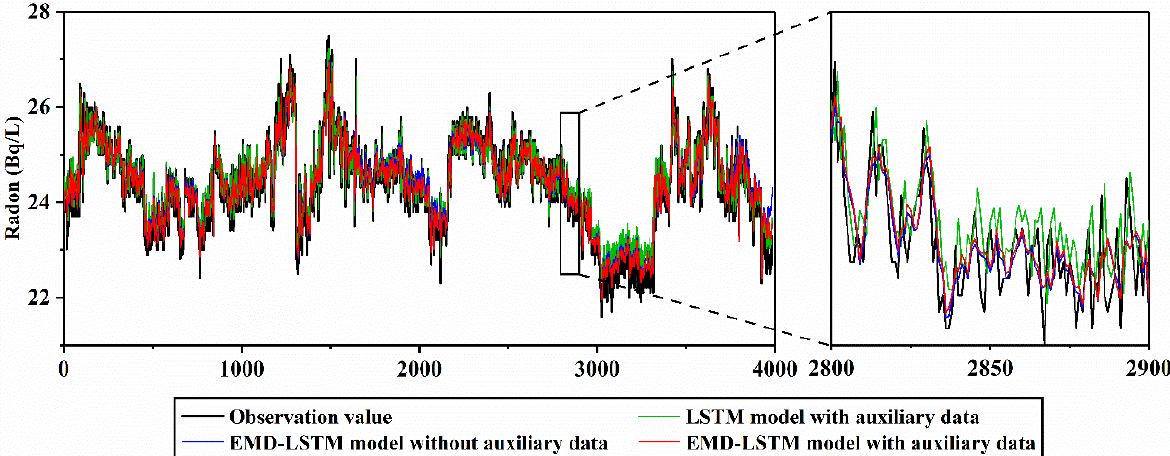
Figure 8. The predicted results of different models, including the LSTM model with auxiliary data, the EMD-LSTM model without auxiliary data, and the EMD-LSTM model with auxiliary data. The R 2 and the RMSE values of the EMD-LSTM model within the validation set without auxiliary data were 0.949 and 0.273, respectively. It demonstrated that the EMD- LSTM model still had good predicted results when only groundwater radon was used as the input